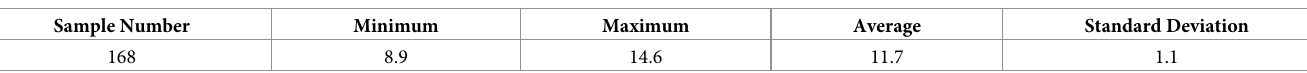
Table 4. Statistics on apple